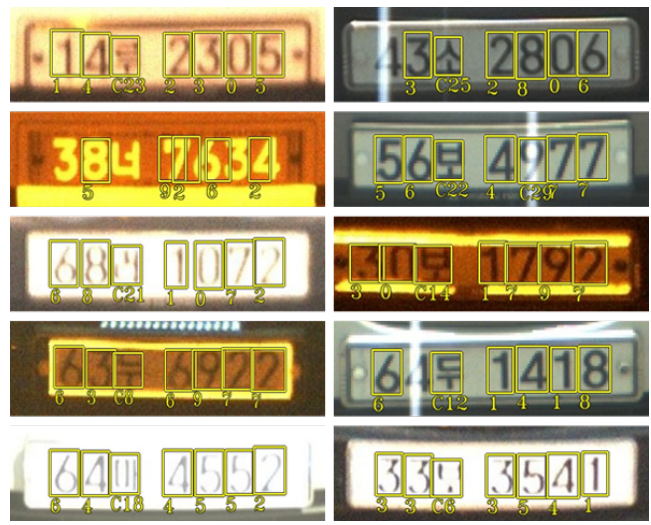
Figure 9. Some failure recognition resultants of Korean LPs by proposed YOLOv2